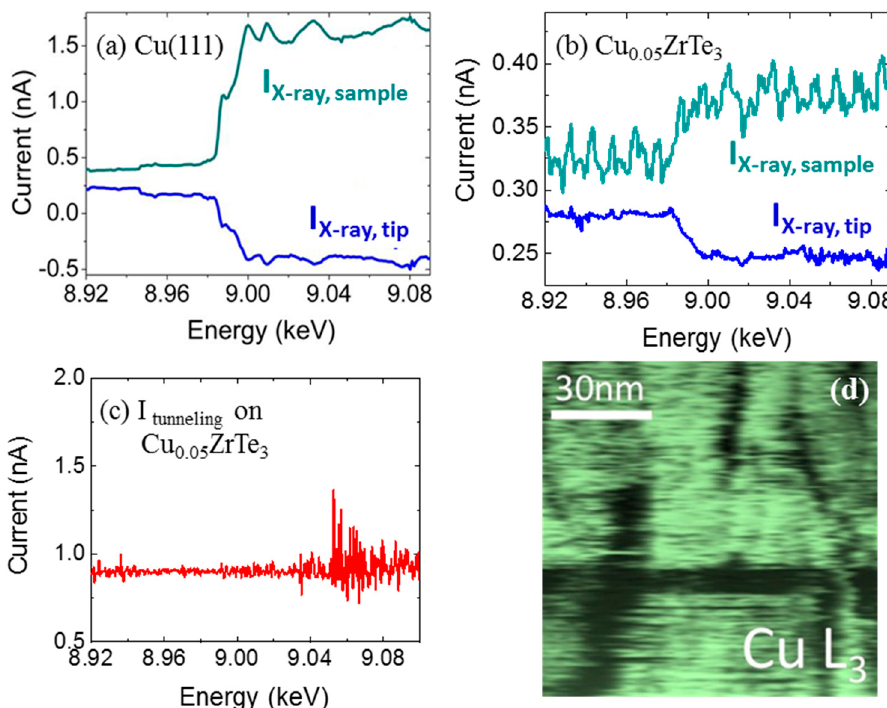
Figure 4. Spectroscopy scans across the Cu K-edge with the tip tunneling over Cu(111) (( a ), [14]) and Cu 0.05 ZrTe 3 ( b ), where simultaneously derived signals from the lock-in amplifiers LIA-sample (I X-ray, sample ) and LIA-tip (I X-ray, tip ) exhibit the characteristic EXAFS spectrum of copper, which is not observed by the Cu 0.05 ZrTe 3 . Note I X-ray, sample in the Cu 0.05 ZrTe 3 spectrum appears to be noisier due to potential instabilities in the beamline. Bias is − 1V, tunneling current is 1.0 nA for Cu 0.05 ZrTe 3 and 0.5 nA for Cu(111); ( c ) tunneling current separated from the sample and tip currents collected from the Cu 0.05 ZrTe 3 ; ( d ) SX-STM image (I-d mode) obtained from Cu 0.05 ZrTe 3 under X-ray illumination at the Cu L 3 absorption edge using the XTIP microscope. The dark areas suggest depletion of Cu at some surface areas.